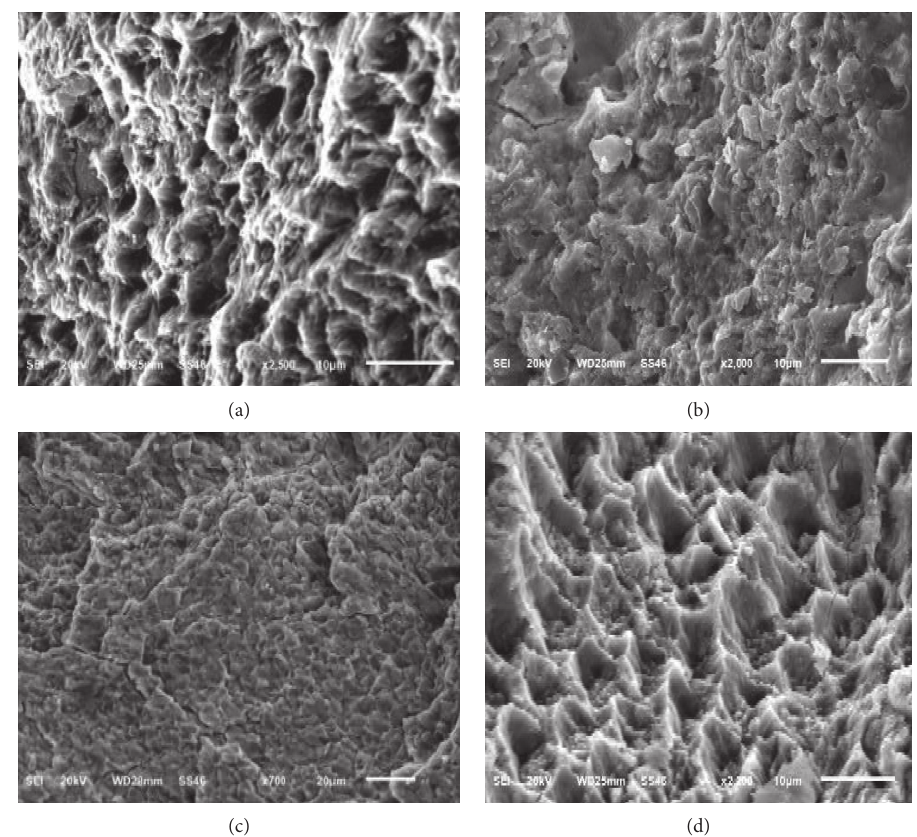
Figure 6: SEM images of laser-etched samples irradiated for 10s at 1W power (a), 1.5W power (b), 2W power (c), and 2.5W power (d).